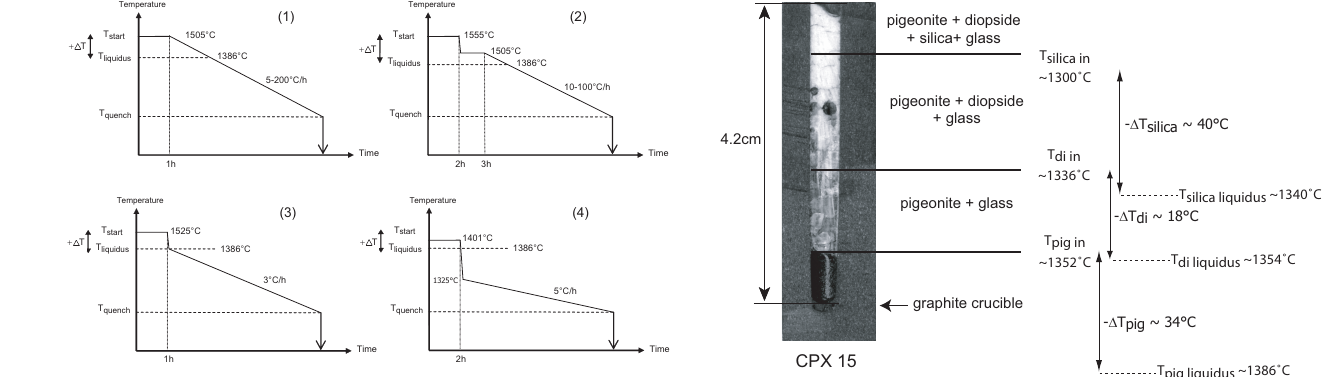
Figure 2. Typical experimental charge. The charge was cut along its length, then polished and scanned. Temperatures of appearance Fig. 2. Typical experimental charge. The charge was cut along its length, then of crystalline phases are compared to their liquidus temperature de- polished and scanned. Temperatures of appearance of crystalline phases are termined in isothermal compared to their liquidus temperature determined in isothermal experiments.